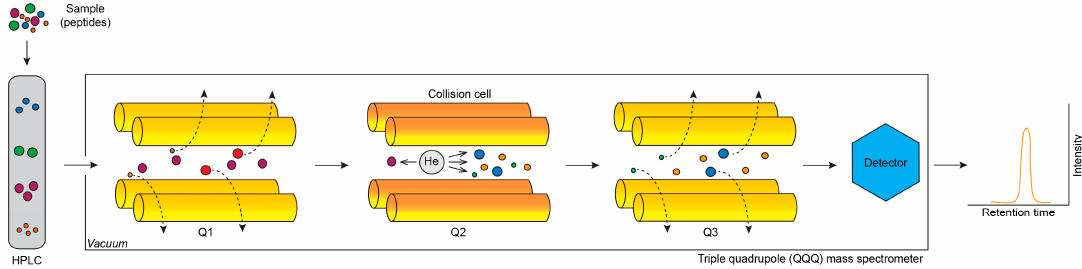
Figure 1. Principle of SRM assay for targeted protein quantification by mass spectrometry. Peptides from sample are separated by reversed-phase HPLC and eluted with specific retention times. Ionised peptides are analysed by triple quadrupole (QQQ) MS instrument. In quadrupole Q1, particular peptide with preset m / z value is selected (precursor ion, purple colour) and passed to Q2, whereas other ions are filtered out (dashed line arrows). In Q2, fragmentation of the selected precursor ion occurs, due to collisions with molecules of inert gas (helium—grey colour). Originating fragment ions are filtered by Q3 (dashed line arrows) and only fragment ion with preset m / z value (yellow colour) is passed to detector, where fragment ion intensity is recorded. As a preset pair of precursor and fragment ion with particular m / z (transition) is measured, the SRM method is very specific.